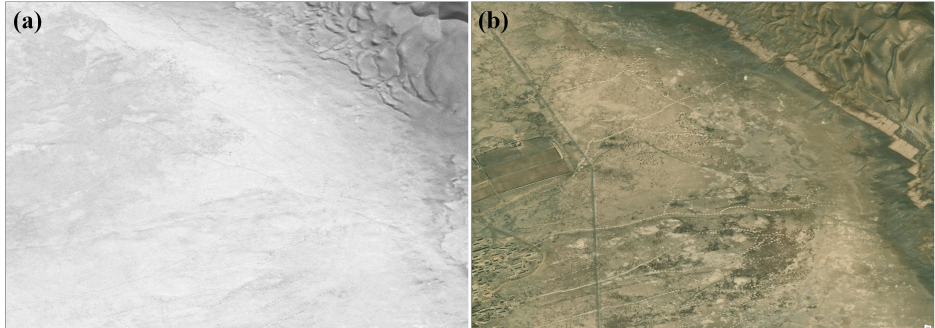
Figure 4. The visual effect of the karez system on remote sensing images is primarily limited to the vertical wellheads, as the other parts of the system are located underground. Figure 4 illustrates this effect, with panel ( a ) showing the karez system on the CORONA panchromatic image and panel ( b ) displaying a map from ESRI’s World_Imagery, which is a multi-band image with sub-meter resolution. The vertical wellheads appear as small dots on the images, with their spatial distribution providing insight into the coverage and density of the karez system.